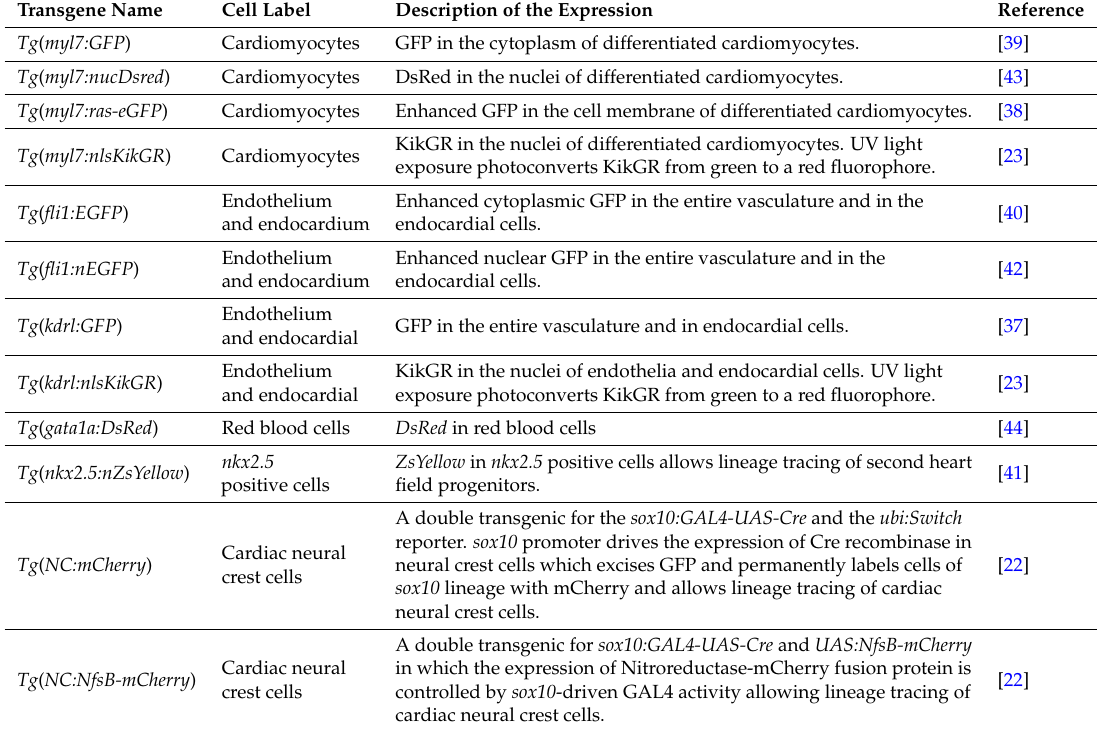
Table 1. Transgenic zebrafish lines that mark different cell types of the heart. Cell Label Description of the Expression Reference GFP in the cytoplasm of differentiated